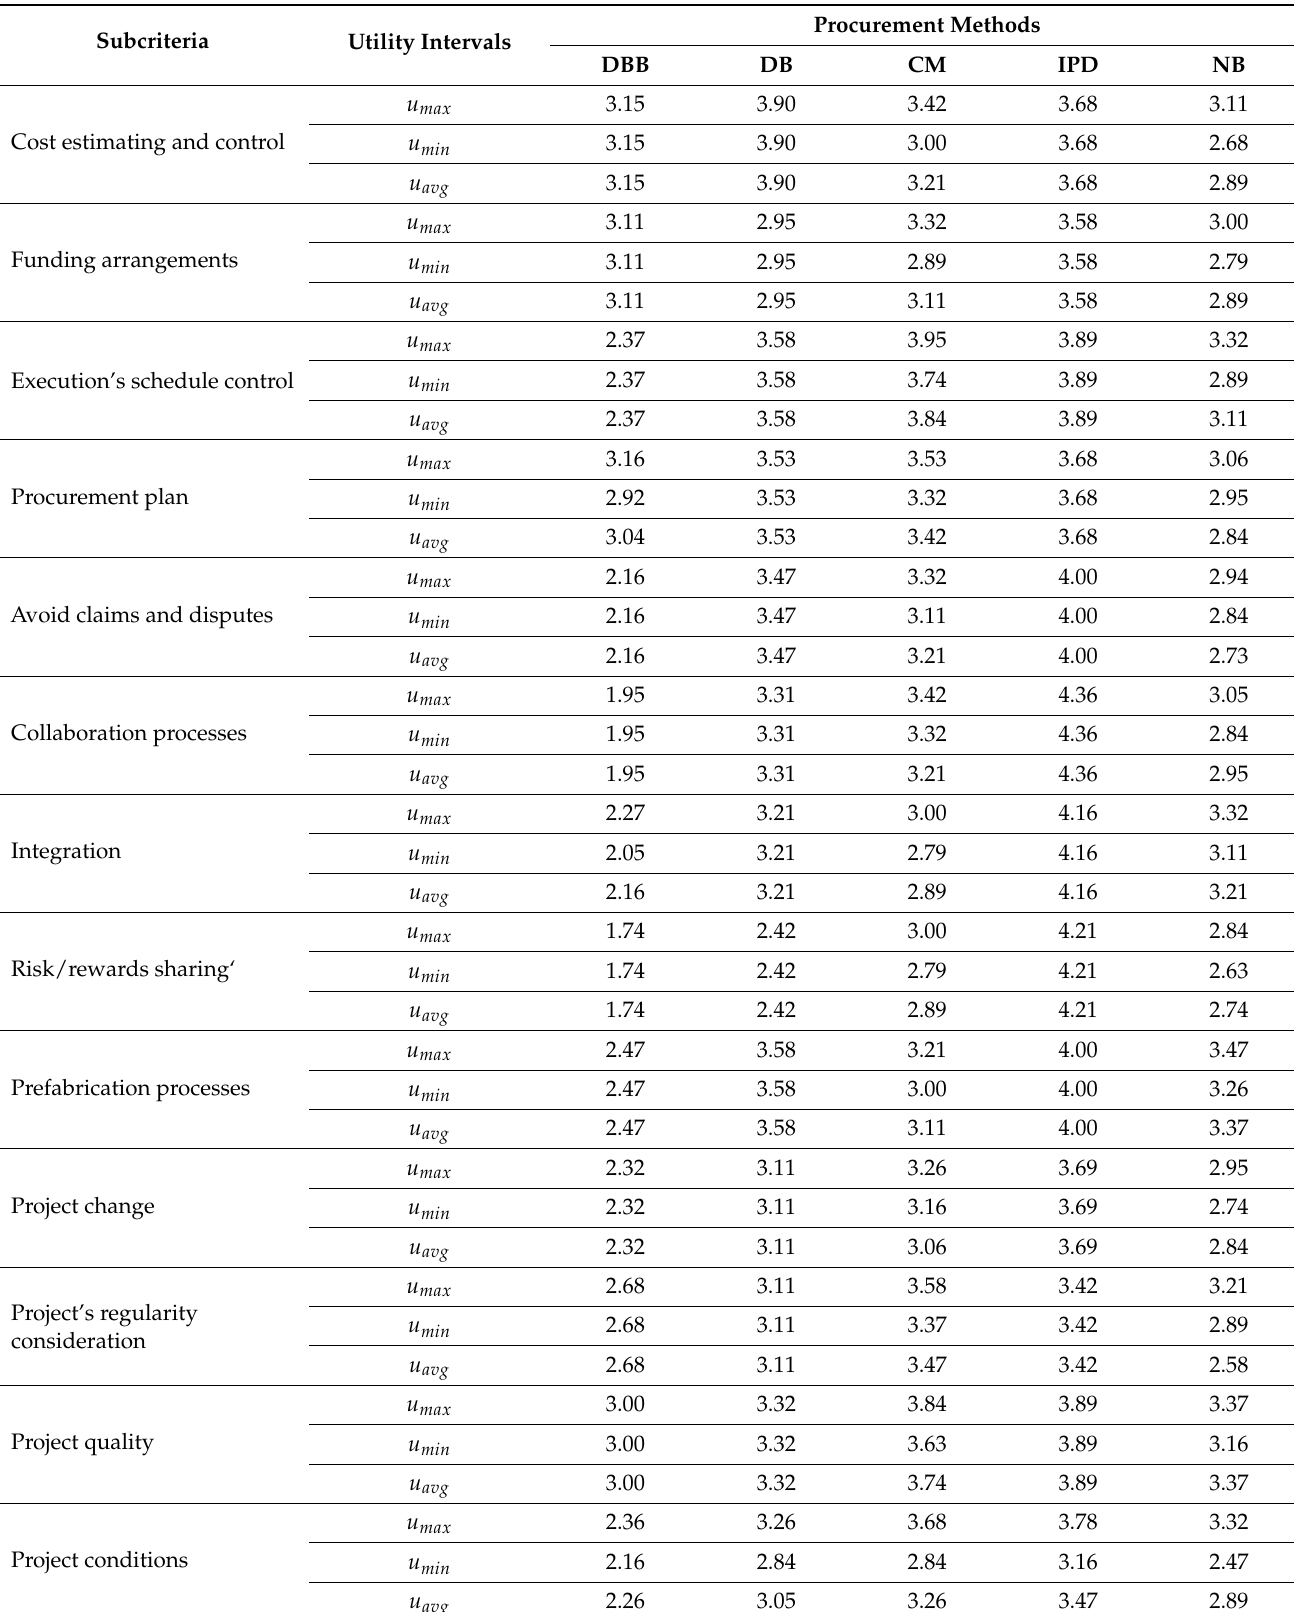
Table 5. Utility intervals for individual procurement types in supporting the